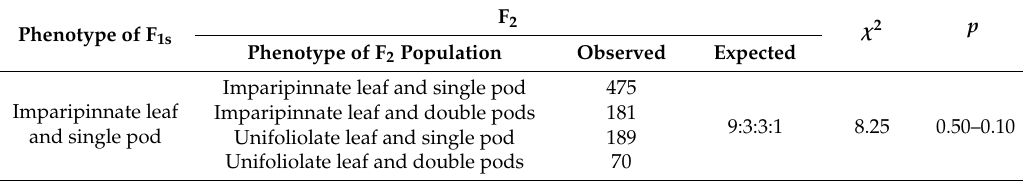
Table 1. Inheritance of the leaf shape (imparipinnate vs. unifoliolate) and number of pods per axil (single vs. double) in F 2 population derived from intraspecific crosses between Sierra and CA